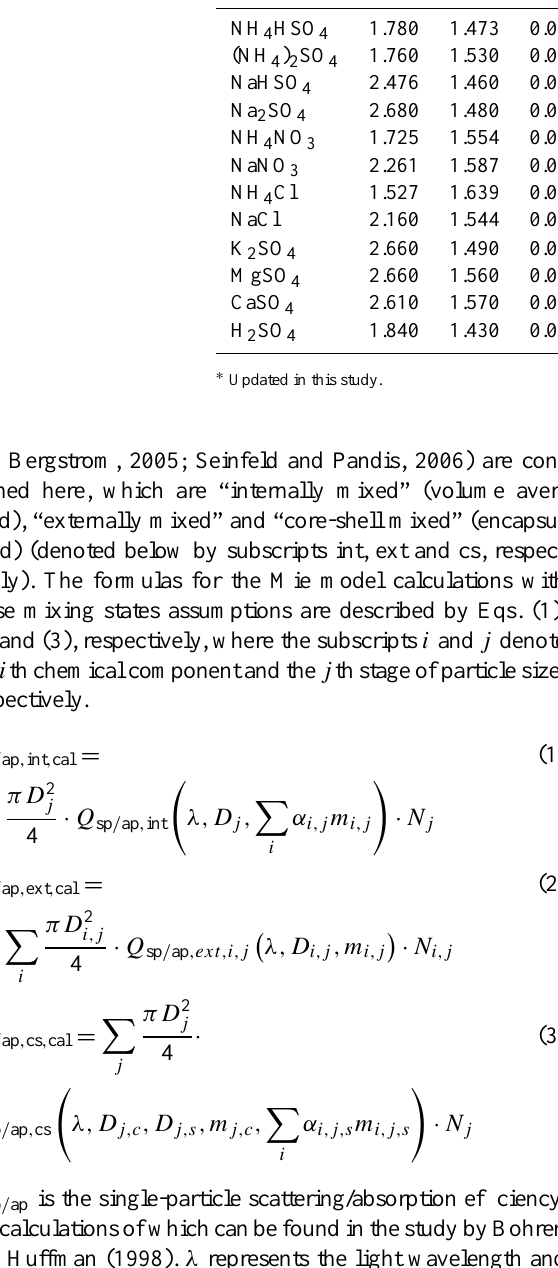
Table 3. Density and optical refractive index of each chemical component. m (= n + ki ) Species ρ Species ρ